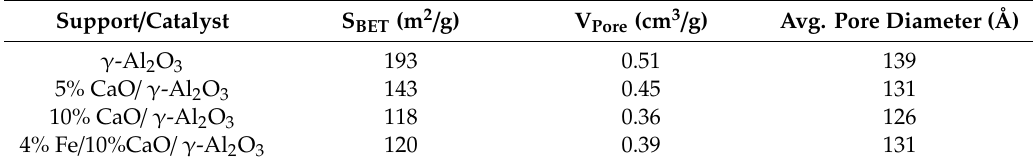
Table 1. Specific surface area, pore volume, and average pore diameter.